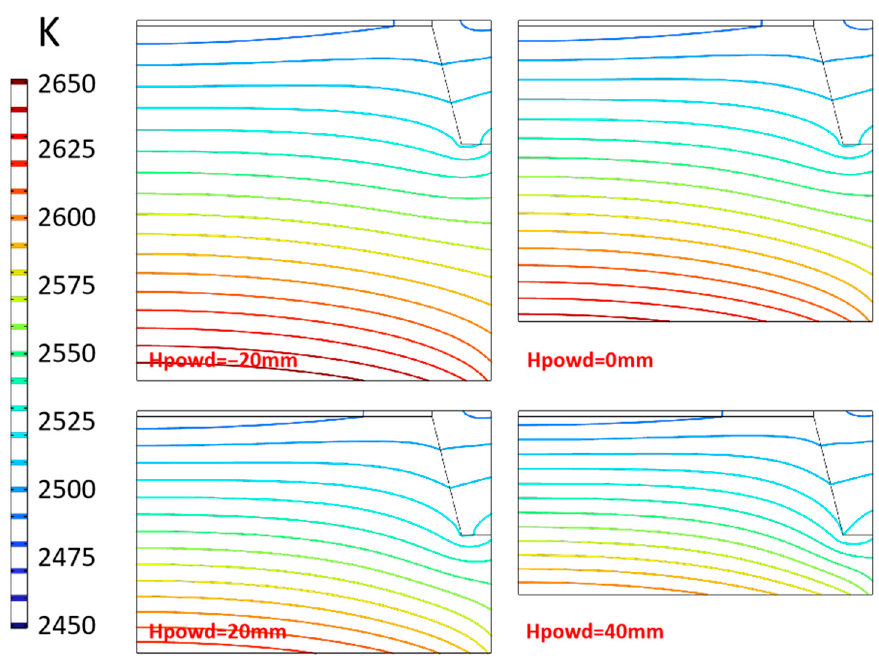
Figure 15. Isotherms distribution in